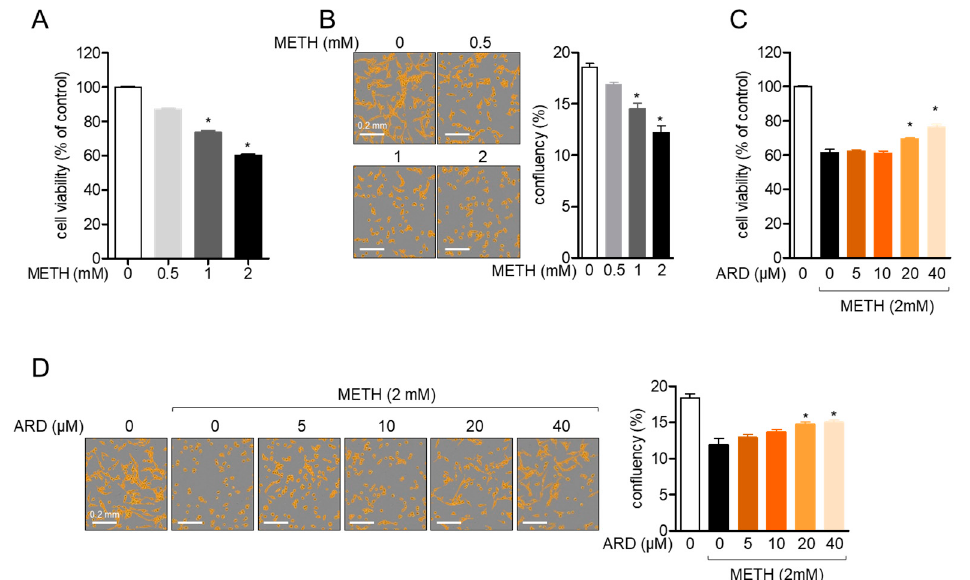
Figure 3. ( A , B ) SH-SY5y cells (5 × 10 3 /well, 96-well plate) were exposed to the indicated concentration (0 to 2 mM) of METH for 24 h. Viability was measured by MTT assay ( A ), and confluency was assessed by IncuCyte imaging system ( B ). ( C , D ) Pre-treated SH-SY5y cells (5 × 10 3 /well, 96-well plate) with the indicated concentration (0 to 40 µ M) of aromadendrin for 1 h were exposed to 2 mM methamphetamine (METH) for 24 h. Cell viability was measured by MTT assay ( C ), and confluency was measured by IncuCyte imaging system ( D ). White bar indicates 0.2 mm. The mean value of three experiments ± SEM is presented. * p < 0.05 between mock-treated cells ( A , B ) or METH-treated cells ( C , D ).